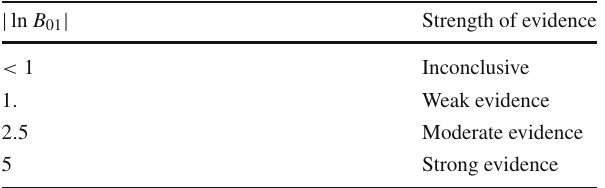
Table 1 The Jeffreys’ scales for interpreting the Bayes factor